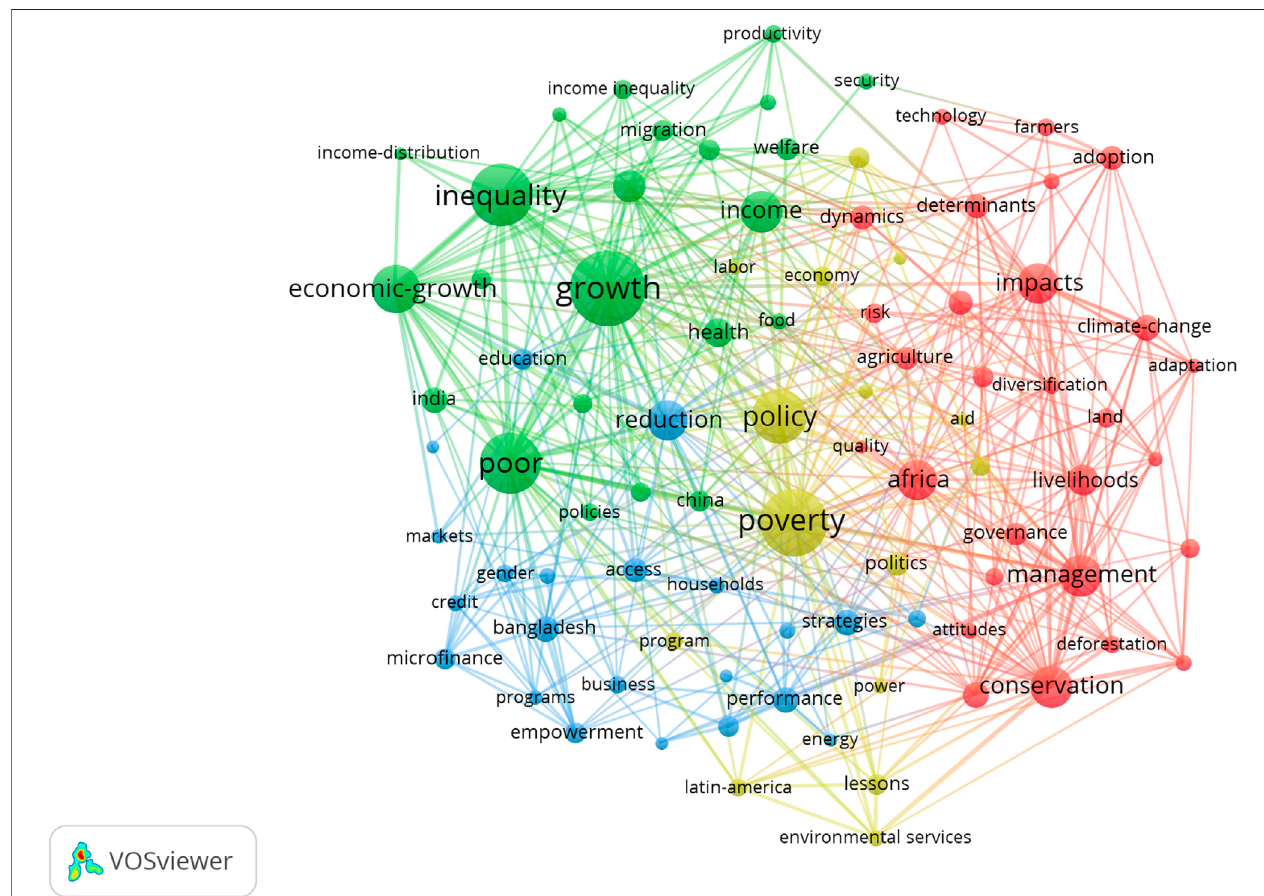
FIGURE 8 | Keywords-plus co-occurrence cluster